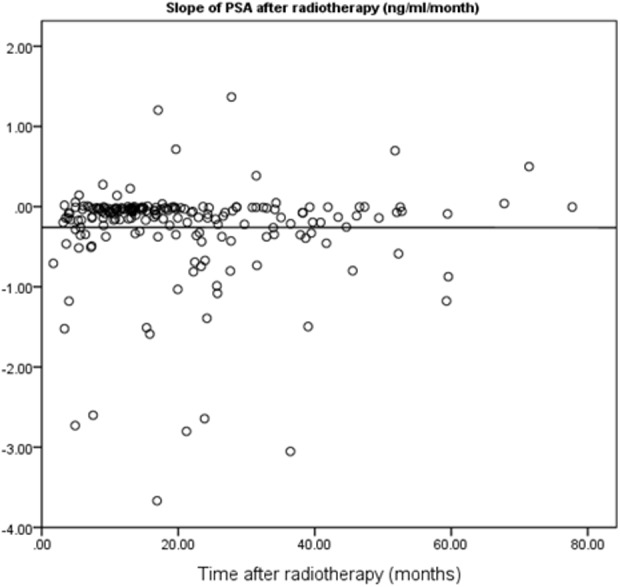
Scatter plot for correlation between follow-up period and PSA slope after RT.